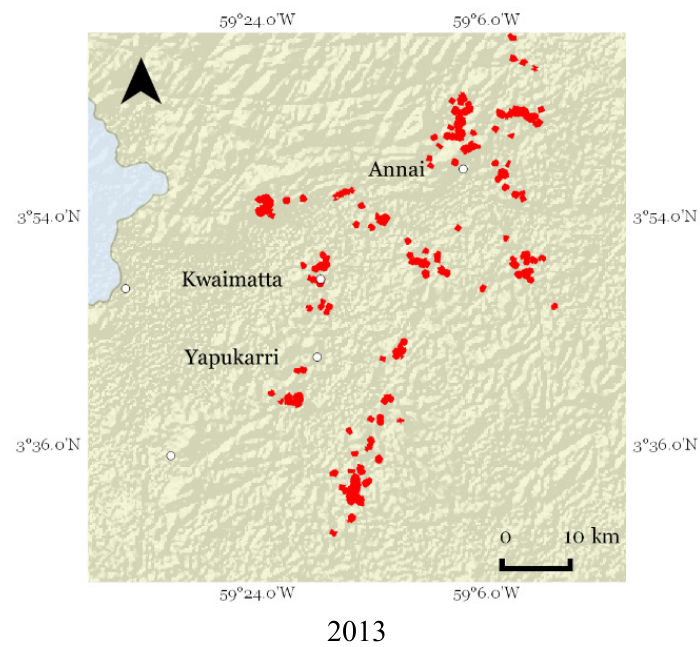
Figure 5. Traditional farming areas in the North Rupununi,